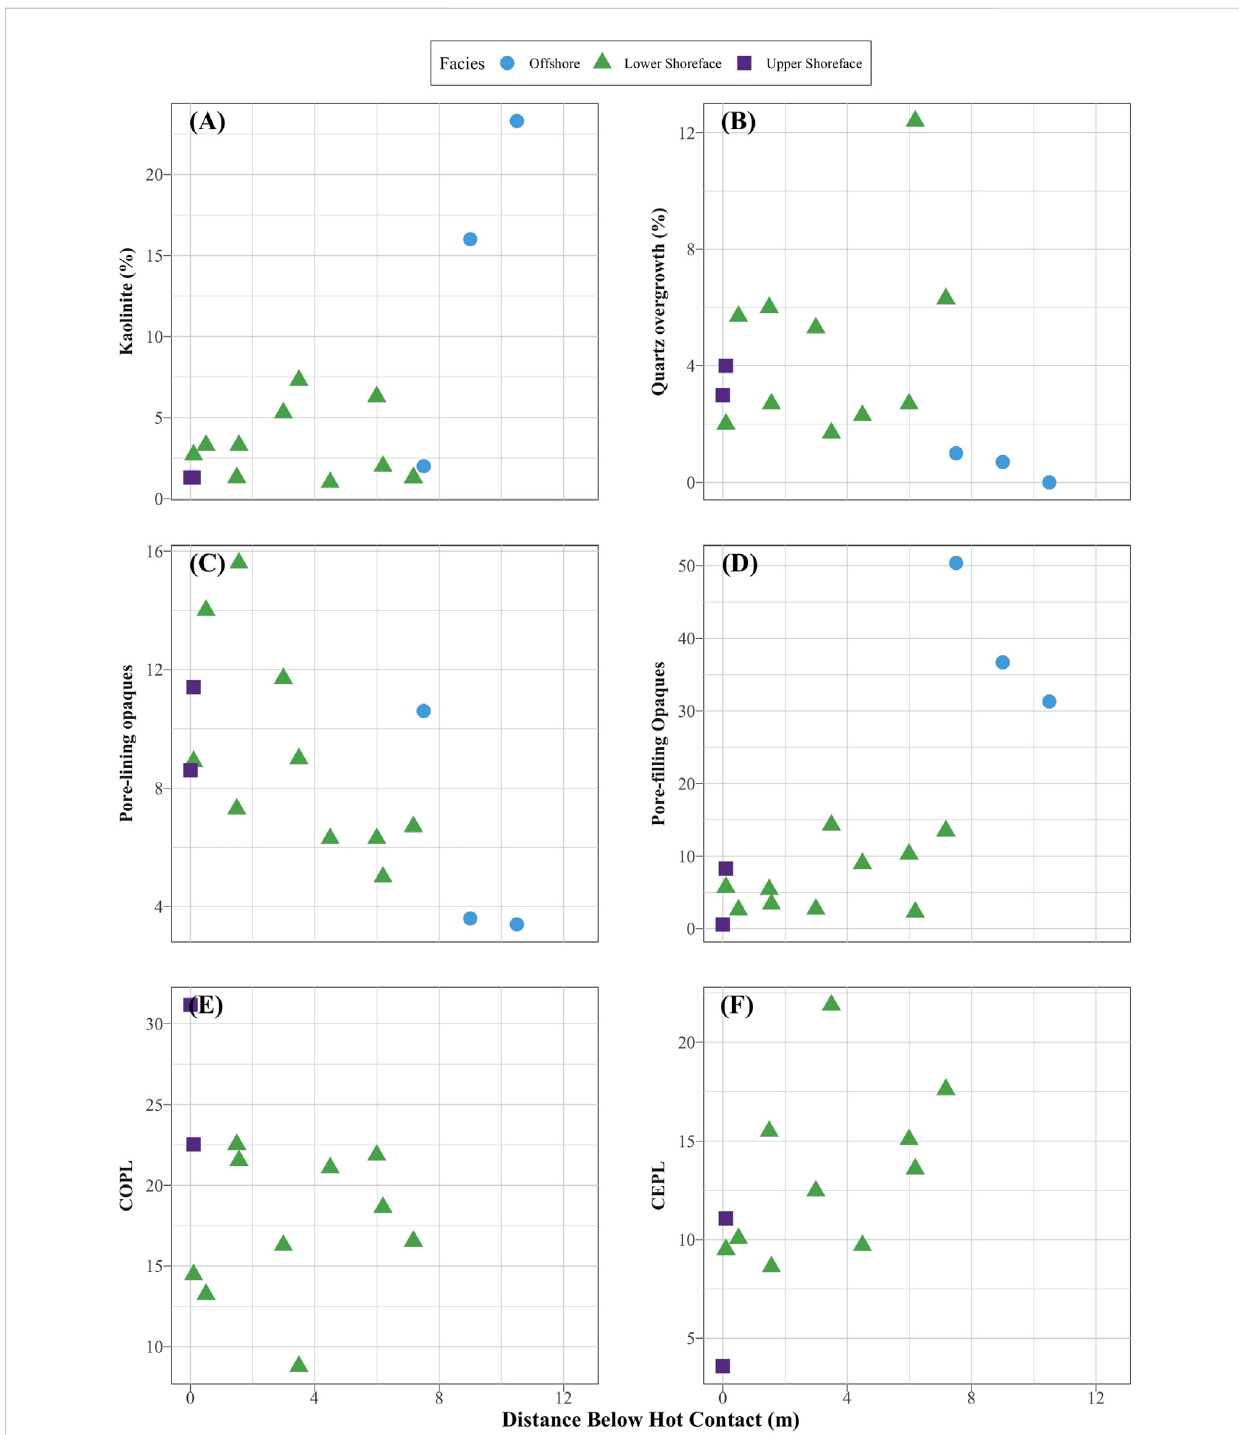
FIGURE 15 Variation ofdiageneticmineralsin relation to thedistancefrom sill contact. (A) An increase inkaolinite content away from thesill contact. (B) Plot of quartz overgrowths against distance from the sill showing a decrease in abundance of quartz overgrowths away from the sill contact. (C) Decrease in pore-lining Fe-oxide minerals away from the sill contact. (D) Increase in pore- fi lling opaque minerals (FeO) away from the sill. (E) Plot of compactional porosityloss(COPL)againstdistancebelowthesillcontactshowingrelativelystablecompactionalporositylossawayfromthesillcontact. (F) Plotof cementational porosity loss (CEPL) against distance below the sill contact showing an increase in cementational porosity loss away from the contact.